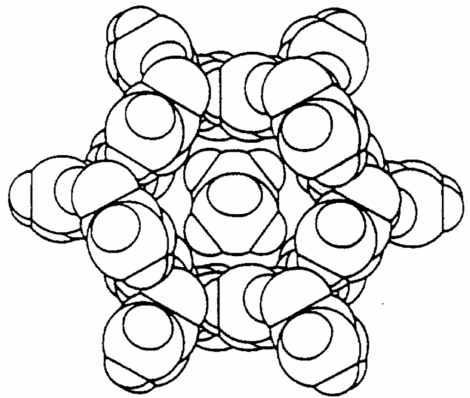
Figure 1. Space-filling drawing of a channel in the urea-n-hexadecane-inclusion compound (IC). Reproduced with permission from [14]. Copyright 1989 Elsevier.